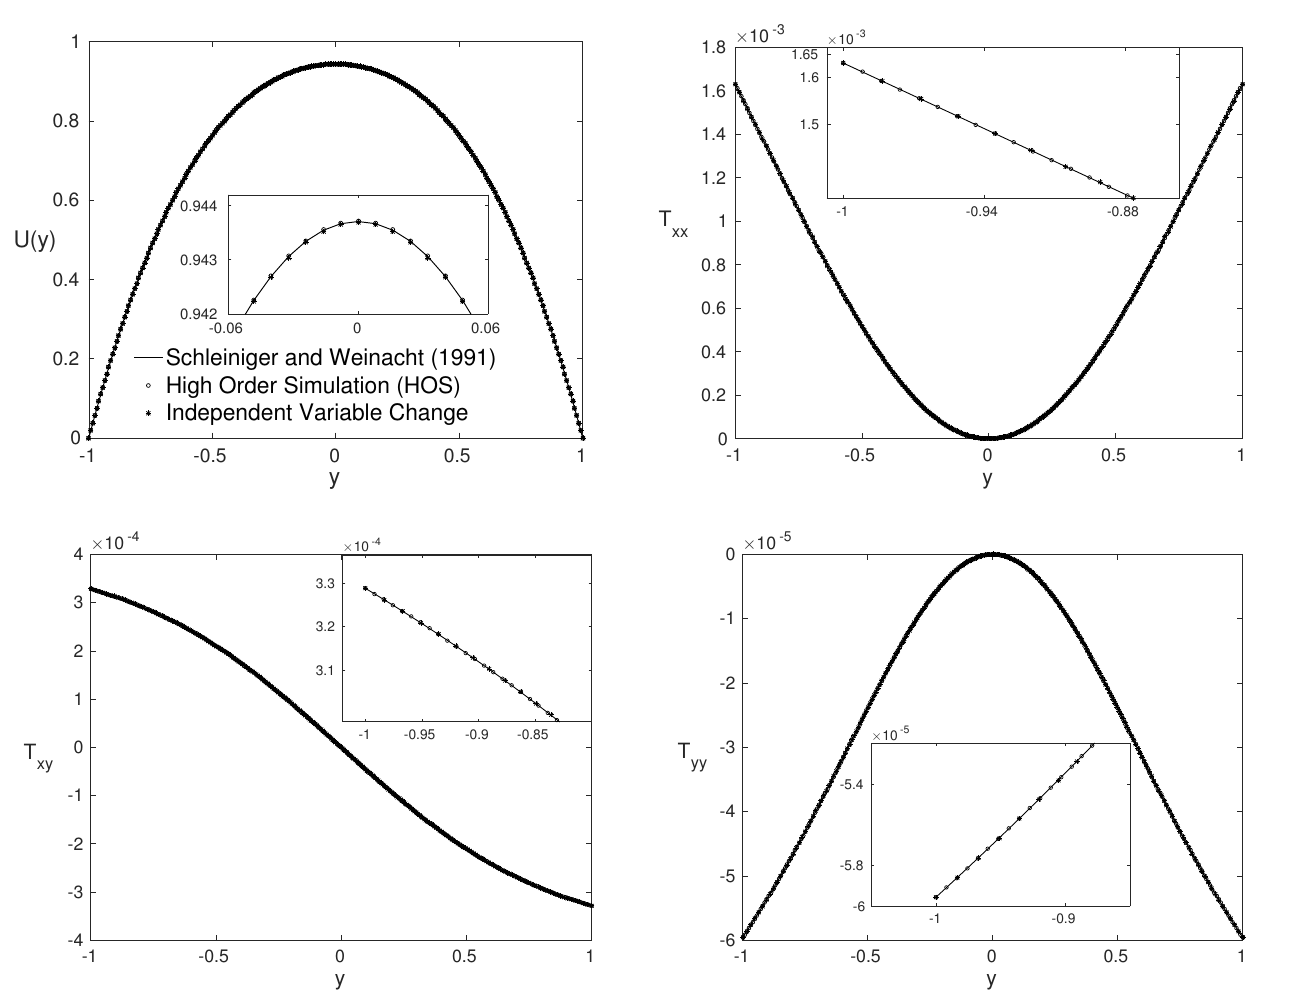
Figure 1. Streamwise velocity U ( y ) and the components of the extra-stress tensor T xx , T xy and T yy variation in the wall- normal direction y . Dimensionless numbers: Re = 2000, β = 0.25, α G = 0.1 and Wi = 2.